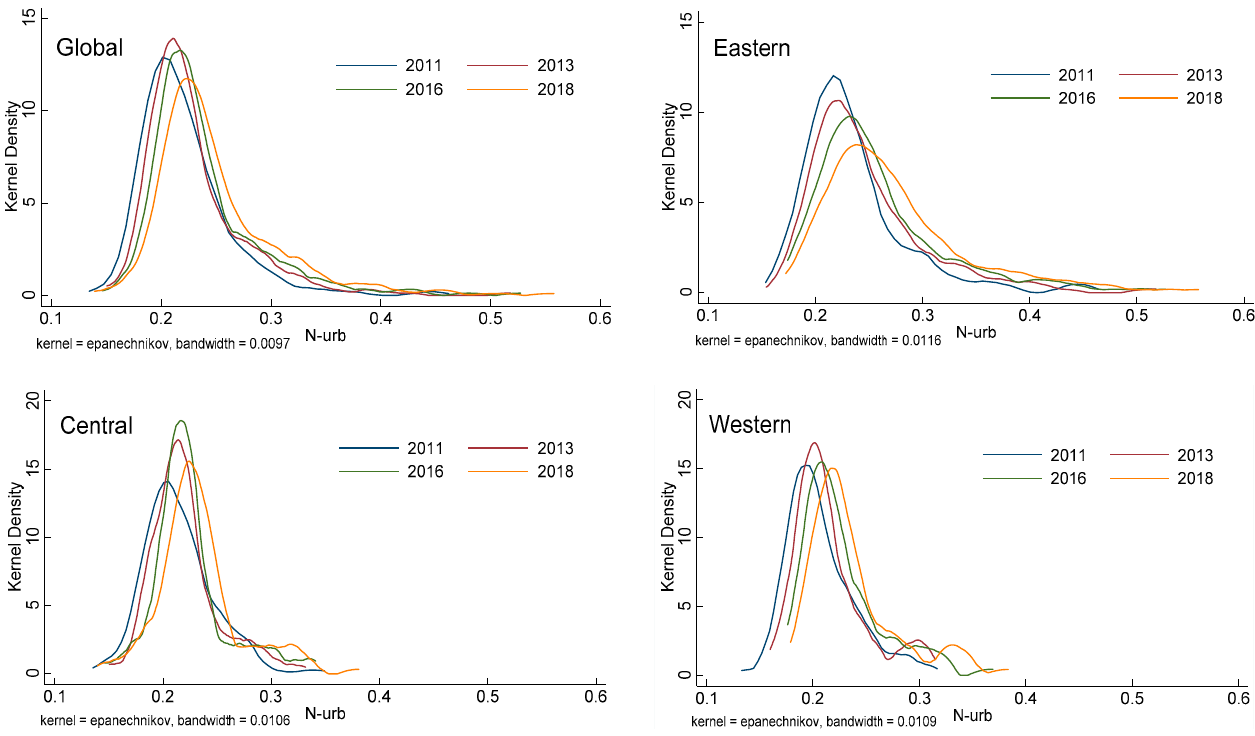
Figure 3. Temporal dynamic evolution characteristics of the new-urbanization in China.